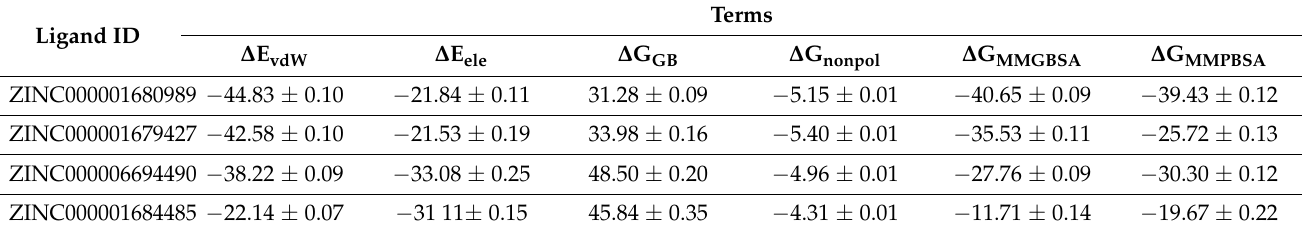
Table 2. Estimated binding affinities and energetic contributions for the systems under